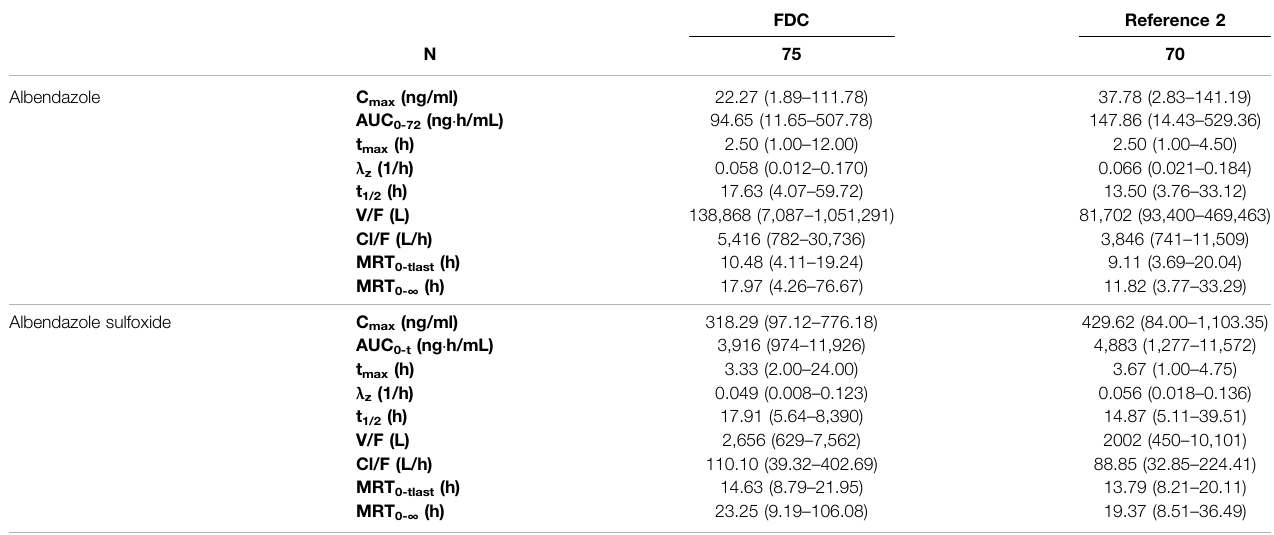
TABLE 2 | Descriptive statistics of the main pharmacokinetic parameters of albendazole and albendazole sulfoxide following the administration of ivermectin/albendazole fi xed-dose combination (FDC) or albendazole (REFERENCE